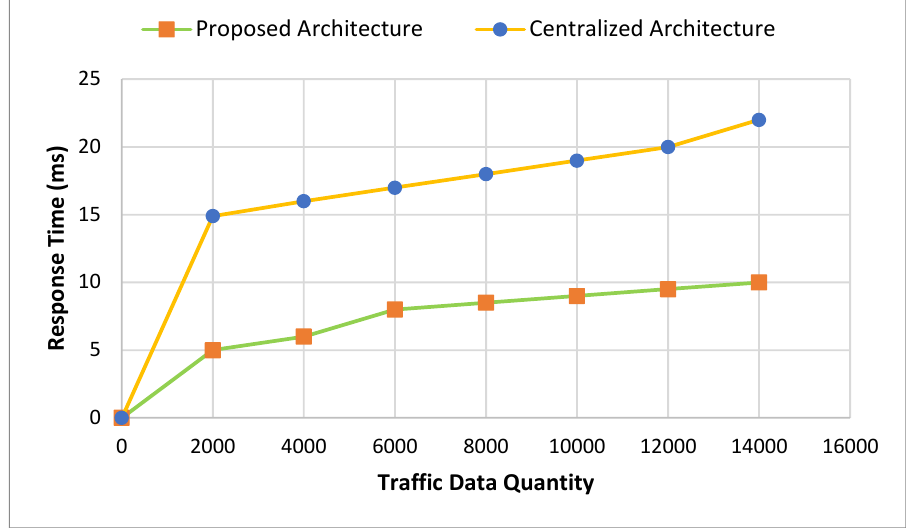
Figure 11. Response time measurement security in data traffic